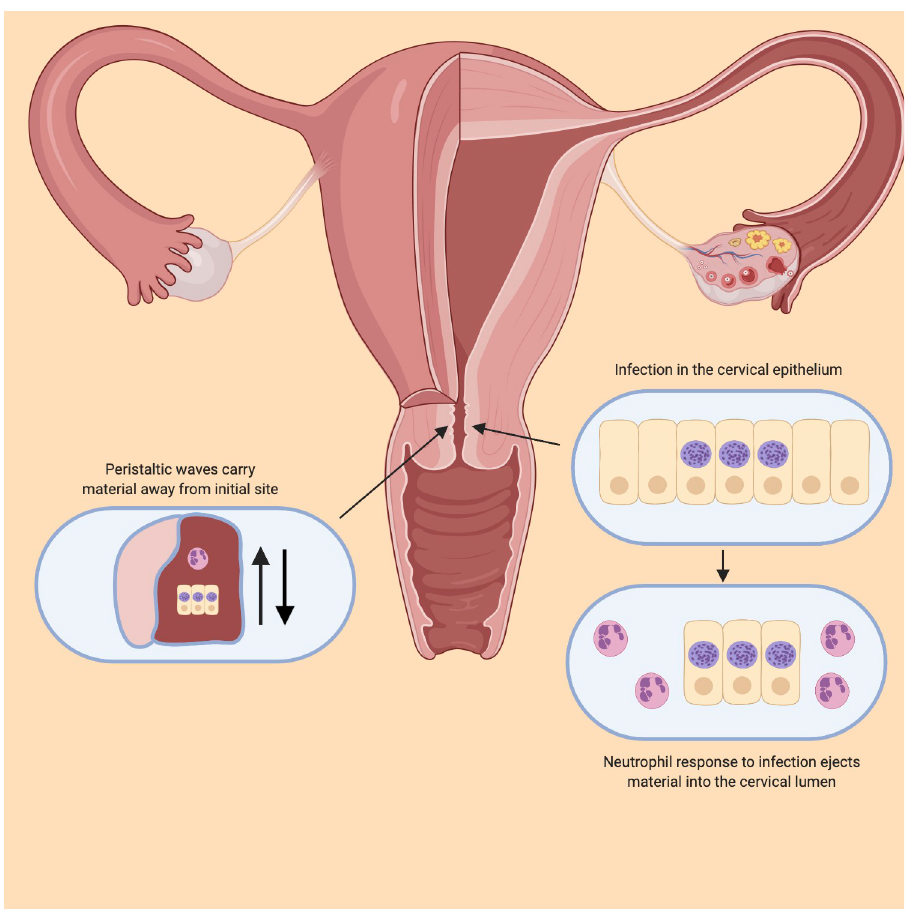
Fig 1. The proposed model of chlamydial ascension. The figure depicts the female reproductive tract and elements that were evaluated in their moderating impact of ascension. The factors evaluated were the chlamydial cell cycle, the host and pathogen interactions including the immune system response and the ejection of infectious material from the epithelium, and the effect of peristalsis in moving material either away or towards the upper reproductive tract depending on the stage of the menstrual cycle. Fig 1 was created with